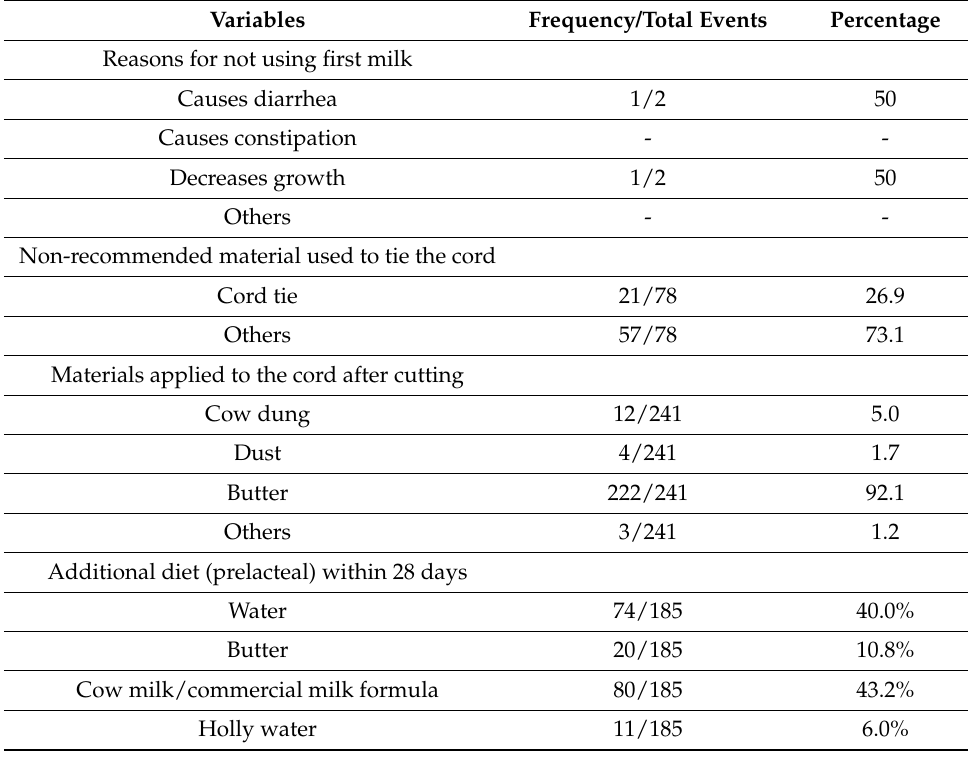
Table 5. Misconceptions and malpractices of Sudanese women towards